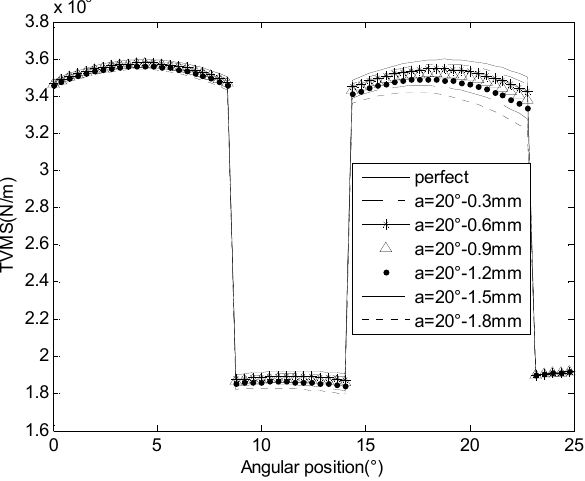
Figure 7. Meshing stiffness of the 14.5° pressure angle.